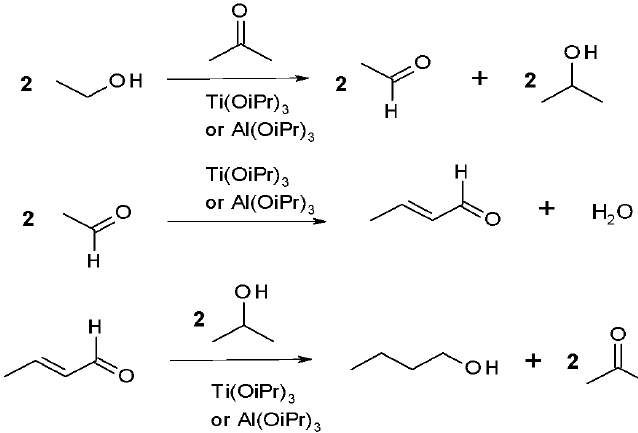
Figure 3. Condensation of dehydrated bioethanol (100% anhydrous state) to butanol in the presence of aluminum (or titanium) isopropanolate.